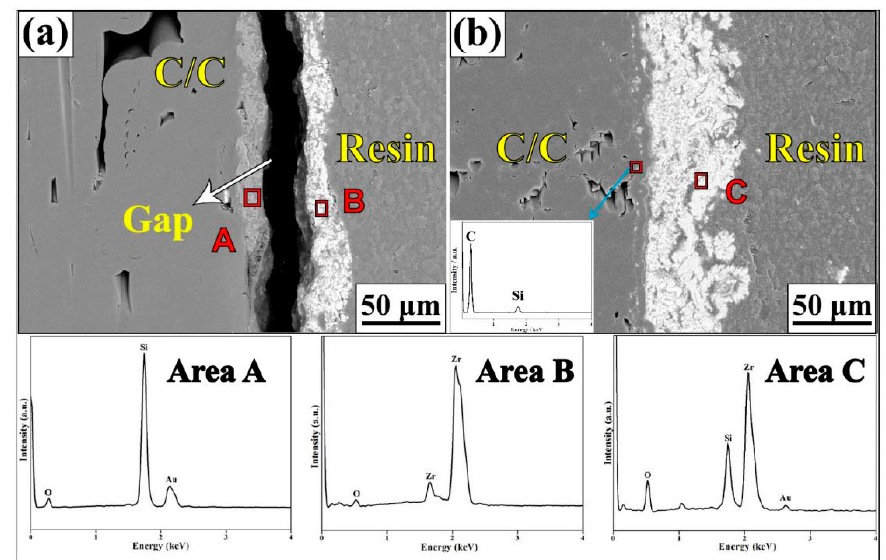
Figure 9. The cross-section morphology and corresponding EDS results of ablated ZrC/SiC and ZrC-SiC coatings. ( a ) ablated ZrC/SiC coating; ( b ) ablated ZrC-SiC coating.